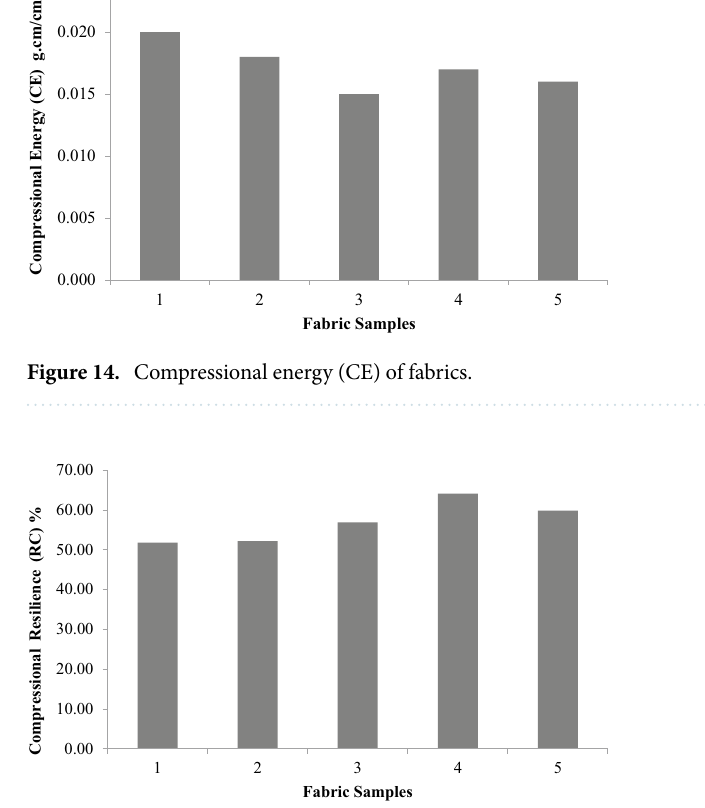
Figure 15. Compressional resilience (RC) % of fabrics.